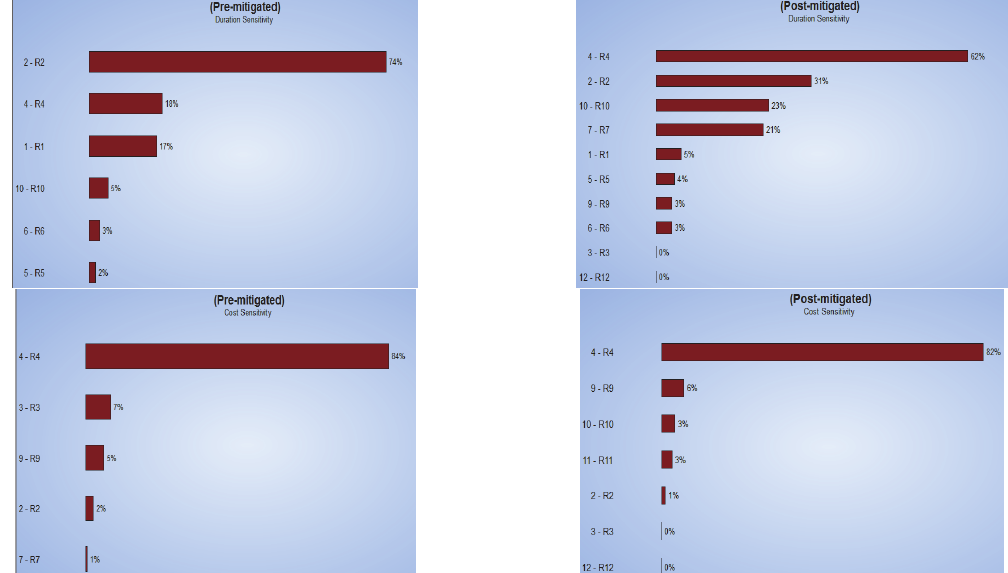
Fig. 9. Sensitive Analysis before and after corrective